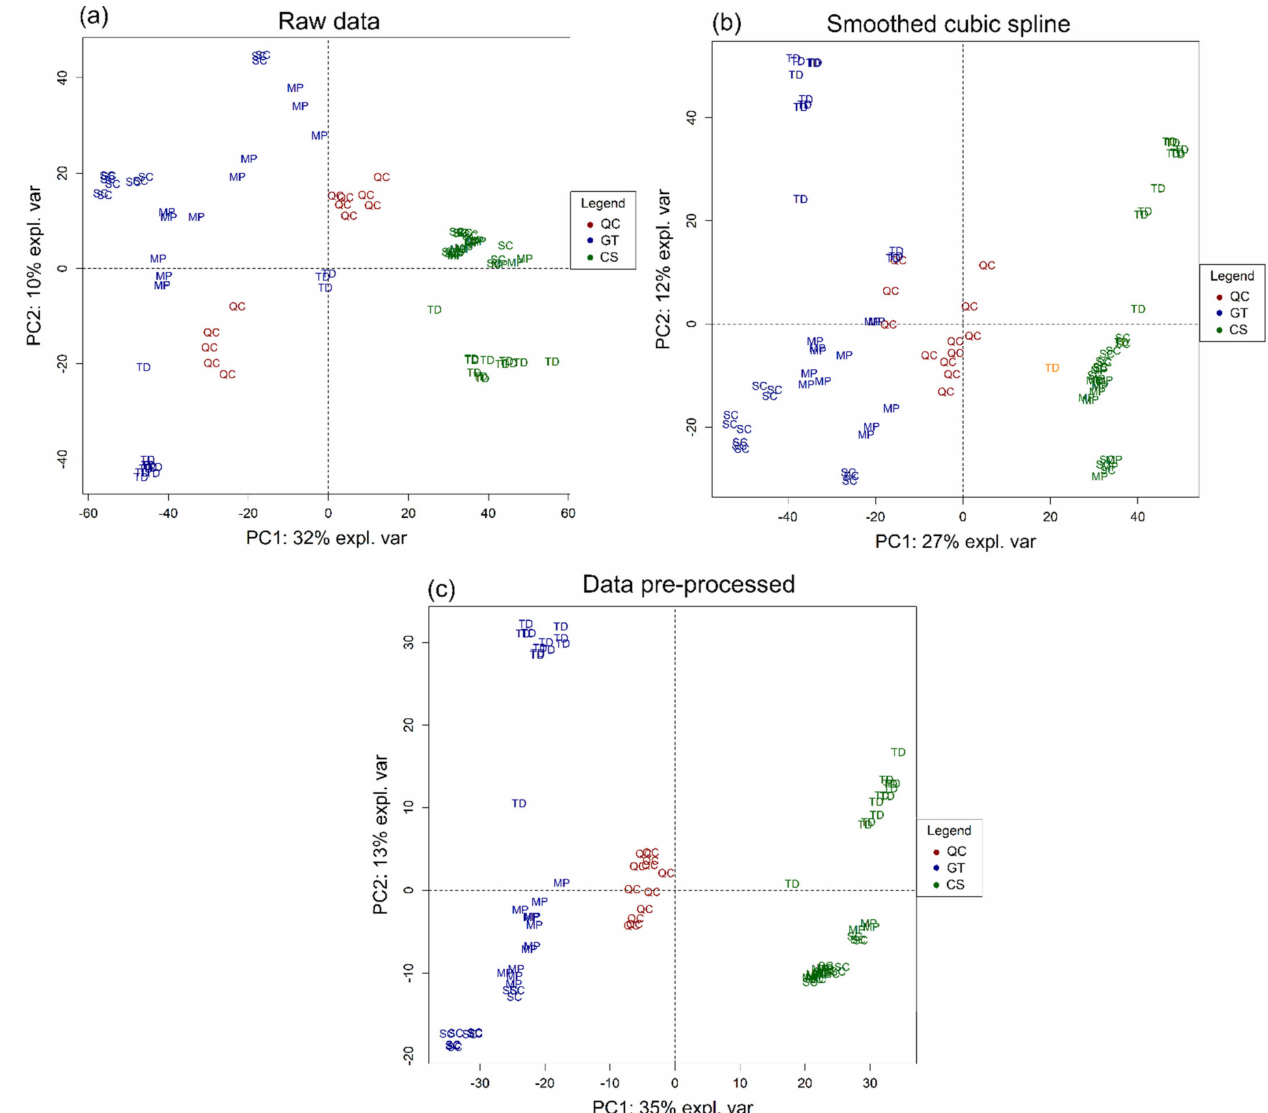
Figure 4. Principal component analysis (PCA) performed for the liquid chromatography (LC) negative ESI mode data during pre-treatment. ( a ) Raw data, ( b ) after smoothed cubic spline and ( c ) pre-treated data. Quality control samples (QCs) are included to verify the quality of the data. TD : wines fermented with sequential inoculation of Torulaspora delbrueckii and Saccharomyces cerevisiae . MP : wines fermented with sequential inoculation of Metchnikovia pulcherrima and Saccharomyces cerevisiae . SC : wines fermented with monoculture of Saccharomyces cerevisiae